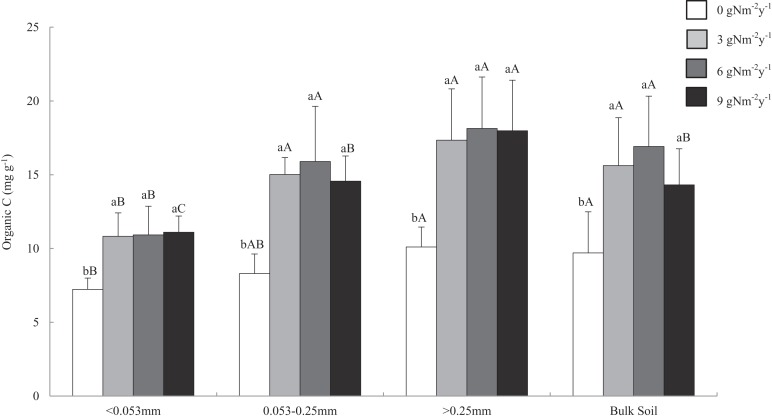
Distributions of organic C content in soil aggregates and bulk soil of different N addition treatments.Values followed by a different lowercase letters indicate significant difference among the N addition treatments, values followed by a different uppercase letters indicate significant difference among the aggregate size. P < 0.05, n = 6.